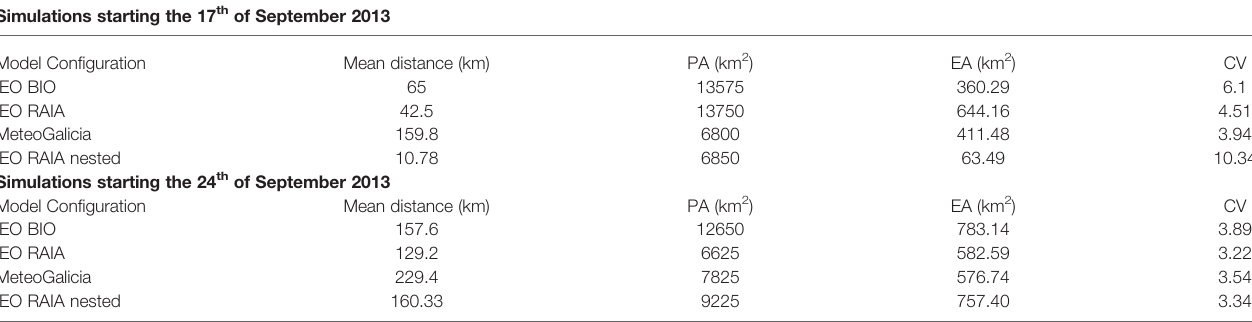
TABLE 3 | Dispersal Kernel indices [Mean Distance, Positive Area (PA), Equivalent Area (EA) and Coef fi cient of Variation (CV)] for the different model con fi gurations run in the 2013 HAB event in W Iberia. Simulations starting the 17 th of September 2013 Model Con fi